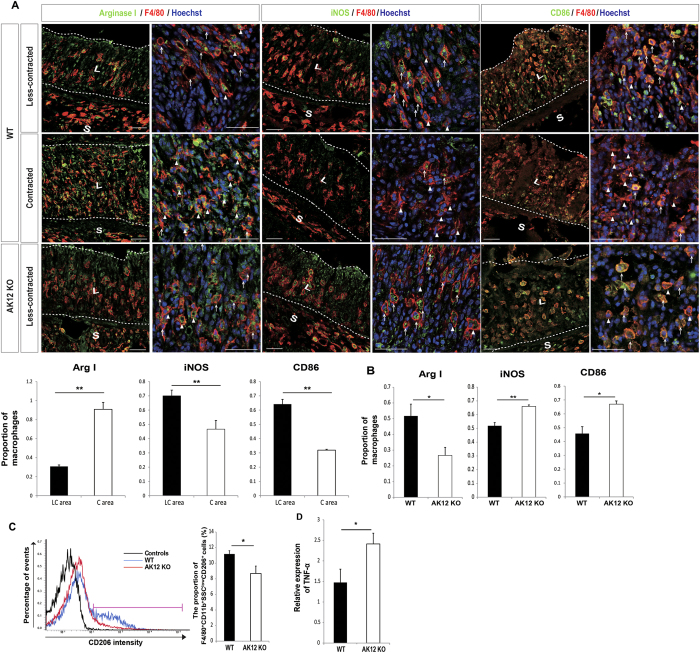
Contracted inflamed colon mucosa generates ramified M2 macrophages.(A) Immunostaining for anti-inflammatory (Arginase I) and inflammatory markers (iNOS and CD86) of macrophages in inflamed colon mucosa of WT and AKAP12 KO mice. Less-contracted and contracted mucosa was selected according to macrophage shapes. Arg1+ macrophages and Arg1− macrophages are marked by arrowheads and arrows, respectively. iNOS+ or CD86+ macrophages and iNOS− or CD86− macrophages are marked by arrows and arrowheads, respectively. Bars: 50 μm. Proportions of arginase I, iNOS and CD86 positive macrophages to total macrophages in less-contracted and contracted mucosa of WT mice were calculated (n = 3 per all group). (B) Proportions of arginase I+, iNOS+ and CD86+ macrophages to total macrophages in WT and AKAP12 KO inflamed mucosa were calculated (n = 5 for CD86+ and n = 4 for iNOS+ in AKAP12 KO inflamed mucosa, n = 3 per all rest group). (C) Representative FACS plot for CD206 positive macrophages in WT and AKAP12 KO inflamed colon. Macrophages within pink bars were considered as M2 macrophages. CD206-negative controls are shown in black (n = 4 per group). (D) TNFα mRNA expression in WT and AKAP12 KO inflamed colon were detected by Real-time PCR (n = 4 per group). L: lamina propria (mucosa), S: submucosa. All images are representative of at least 5 mice per group. All panels, P** < 0.01, P* < 0.05. Error bars, s.e.m.